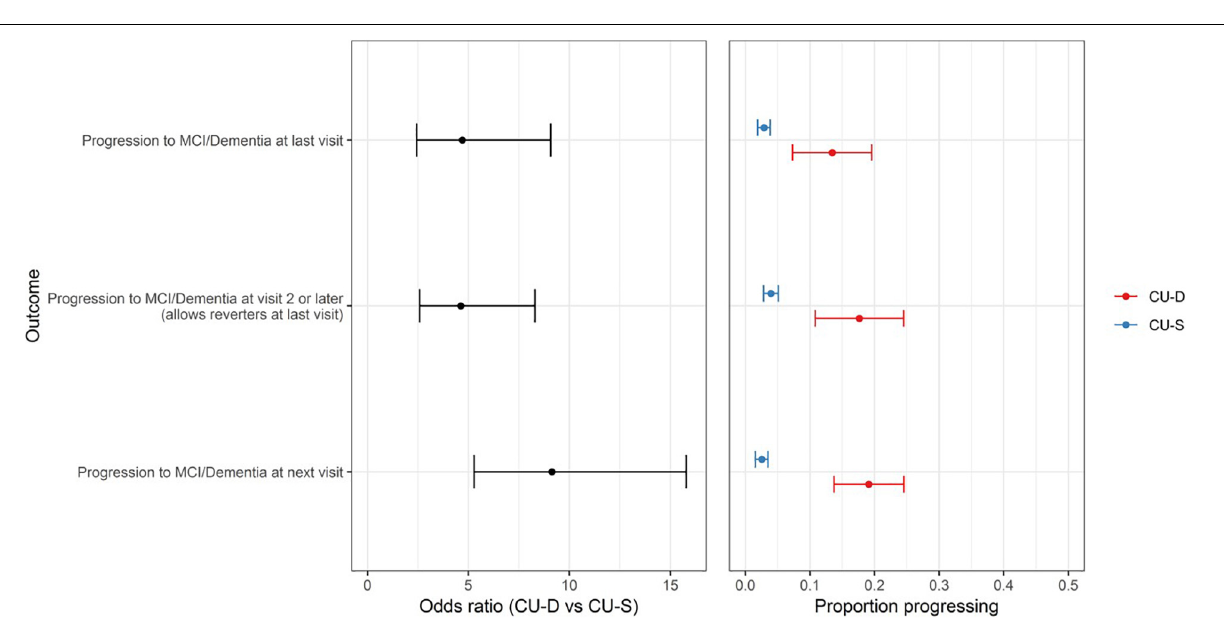
FIGURE 4 | CU-D increases risk of later clinical status in secondary progression outcomes. (Left) Odds ratios and 95% CI’s from logistic regression models showing risk of progression for primary outcome (top row) and secondary outcomes (MCI/Dementia at visit 2 or later; and MCI/Dementia at “next visit” from CU-S or CU-D at previous visit). CU-S, cognitively unimpaired-stable; CU-D, cognitive unimpaired-declining. (Right) 95% confidence interval for proportion progressing to MCI/Dementia, by CU-D and